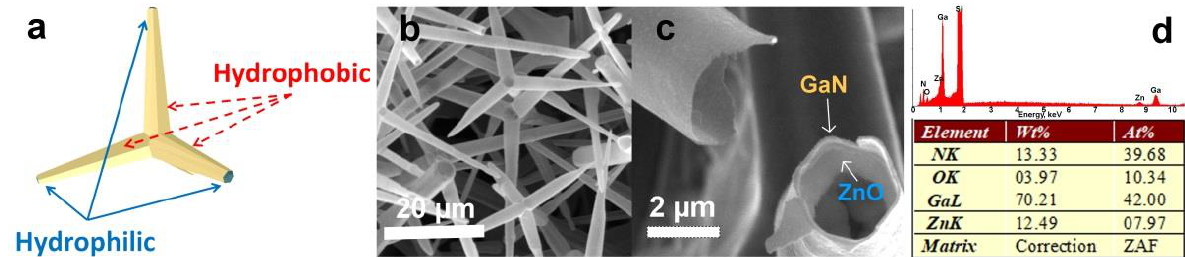
Figure 1. ( a ) Schematic representation of a single Aero-GaN microtetrapod exhibiting both hydrophobic and hydrophilic properties; ( b ) an SEM picture taken from a network of Aero-GaN microtetrapods; ( c ) cross-sectional views of individual microtubes, whose chemical compositions are presented in ( d ).